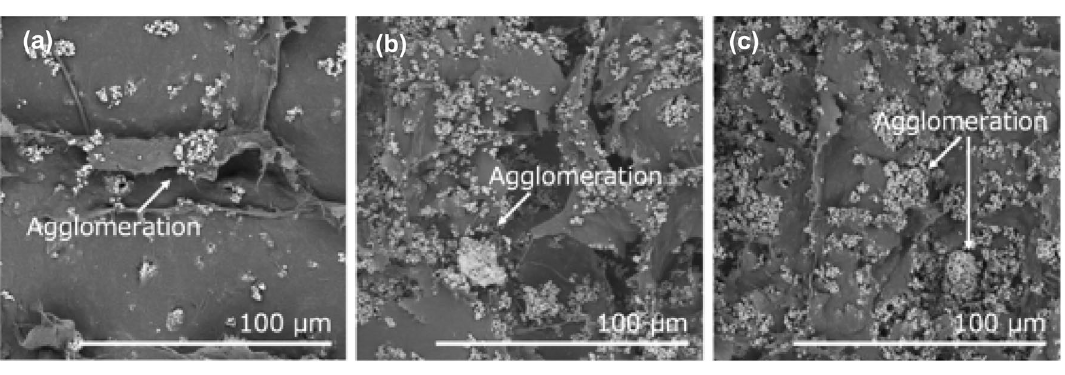
Figure 4. SEM images of the CNF–CoFe 2 O 4 composite papers with different CoFe 2 O 4 contents: ( a ) 10.9, ( b ) 21.0 and ( c ) 27.5